Question: What form of chart is displayed?
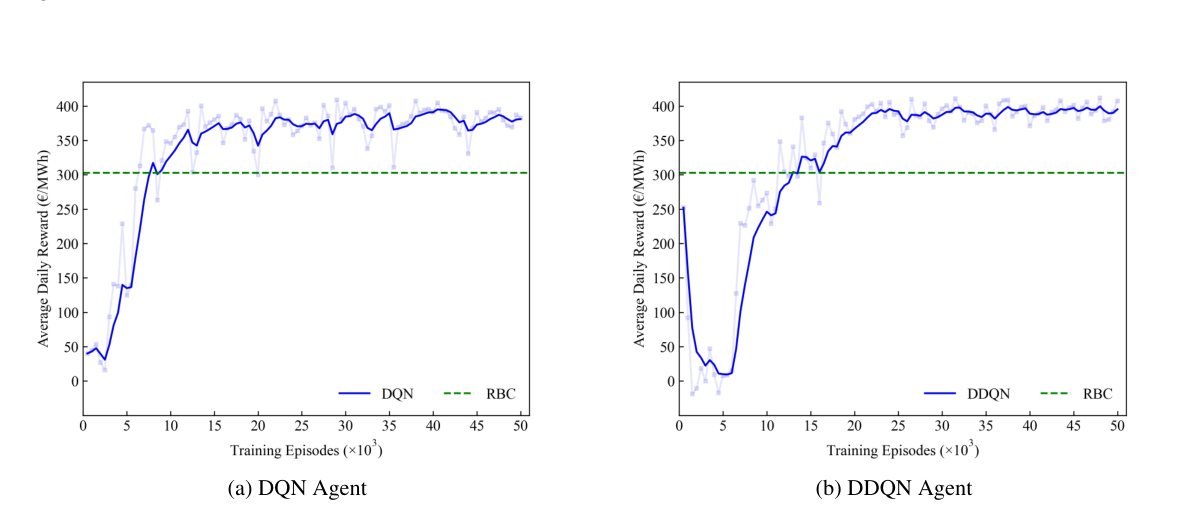
Answer: line